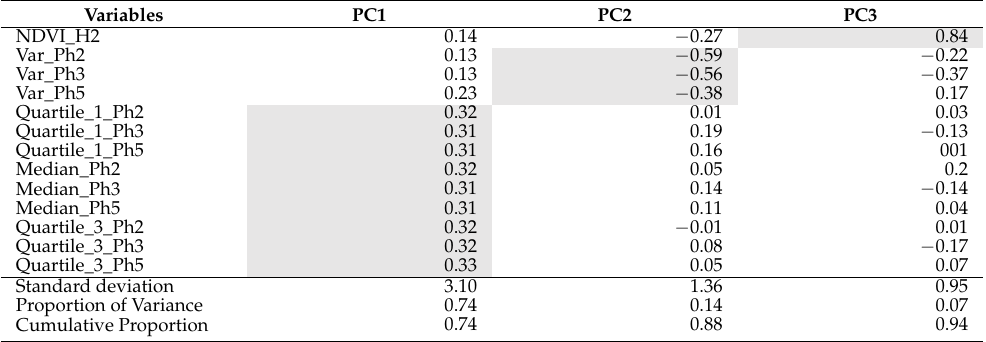
Table A1. Three first principal components from the PCA for all the NDVI time-series variables and H2. Background color highlights those variables with higher explanatory power for each principal component.